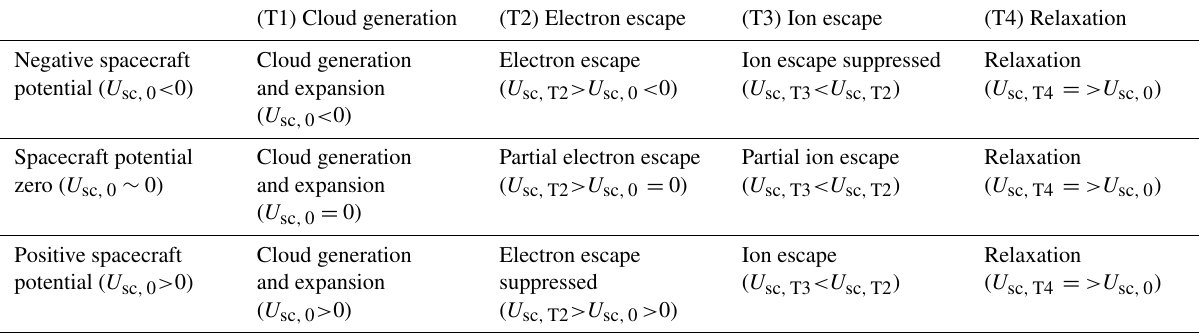
Table 1. Explanation of impact process signal shape illustrated in Fig.